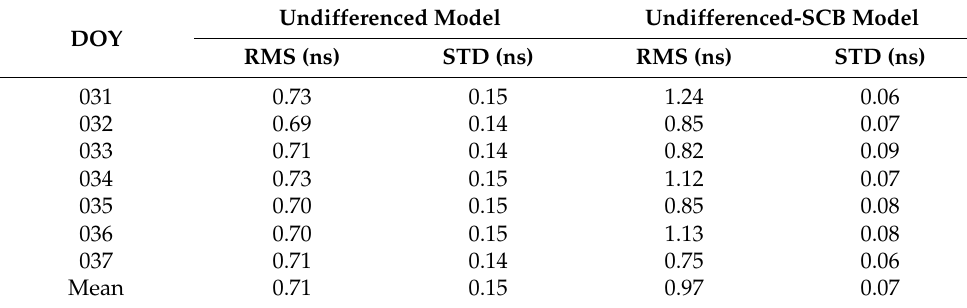
Figure 9. Time series of the clock biases with respect to the IGS final products on DOY 031. Different colors correspond to different satellites, and mean values are removed. Table 4. The RMS and STD of clock estimates using different models when compared to the IGS final products from DOY 031 to 037.